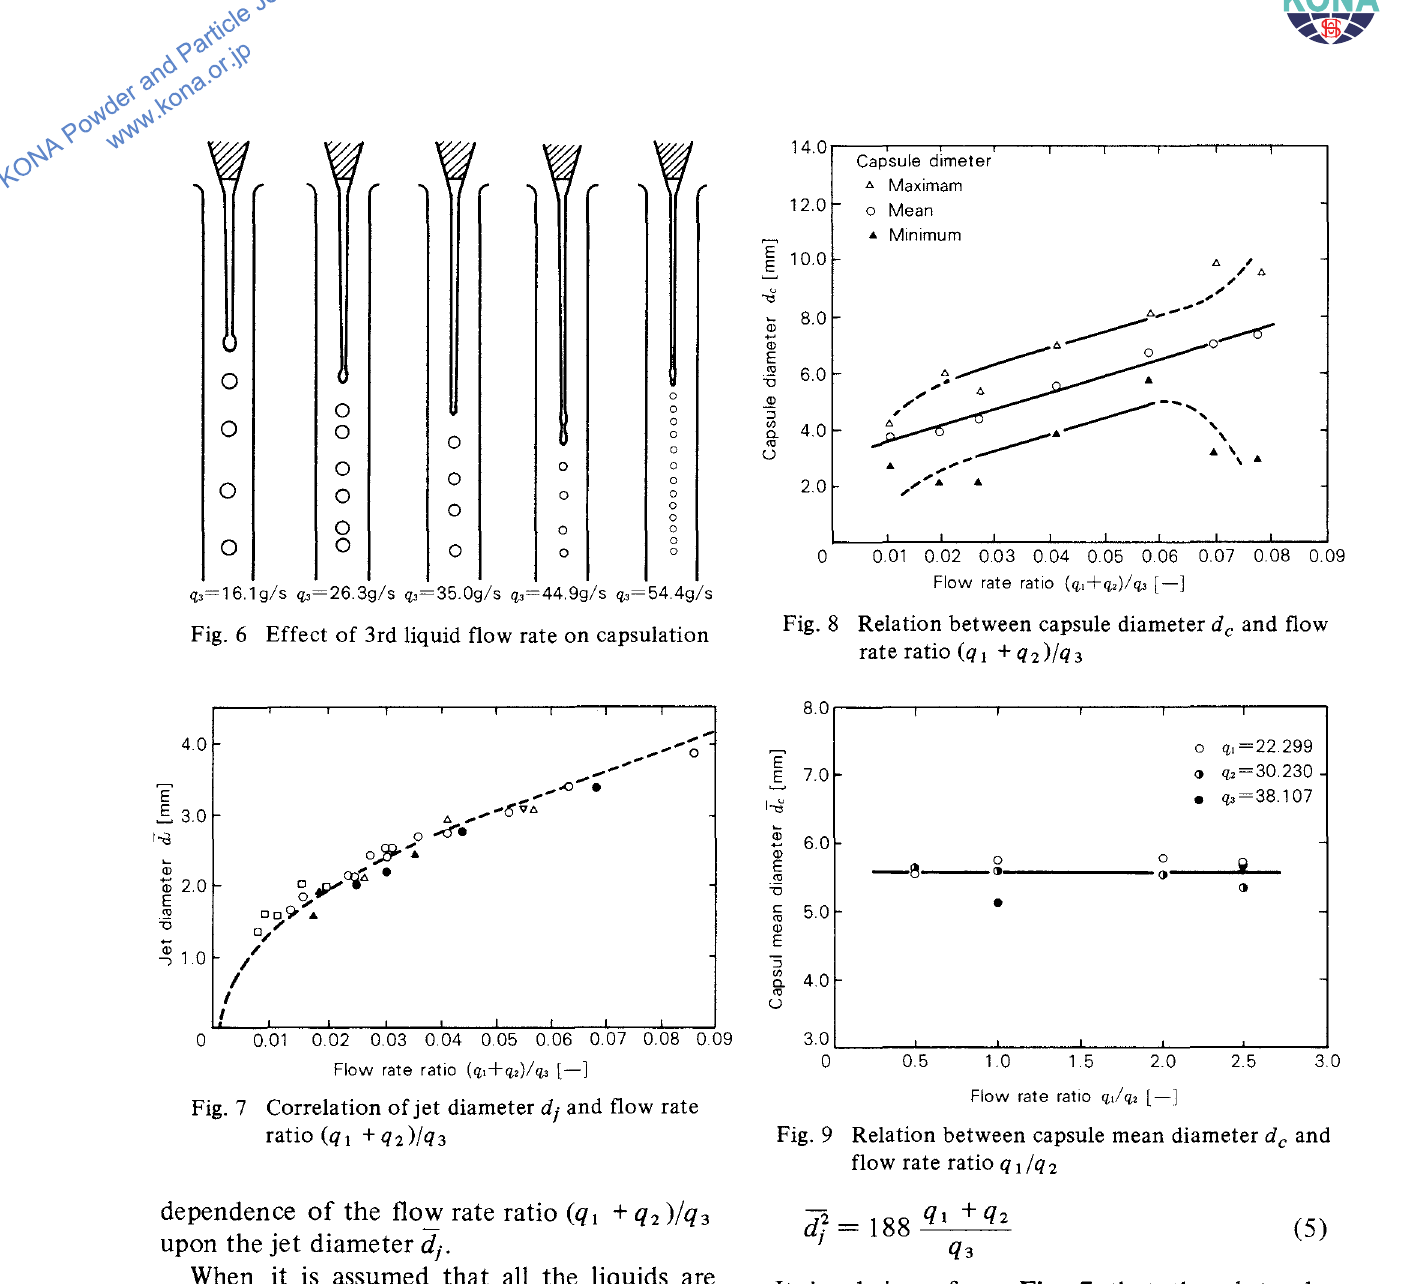
Fig. 9 Relation between capsule mean diameter de